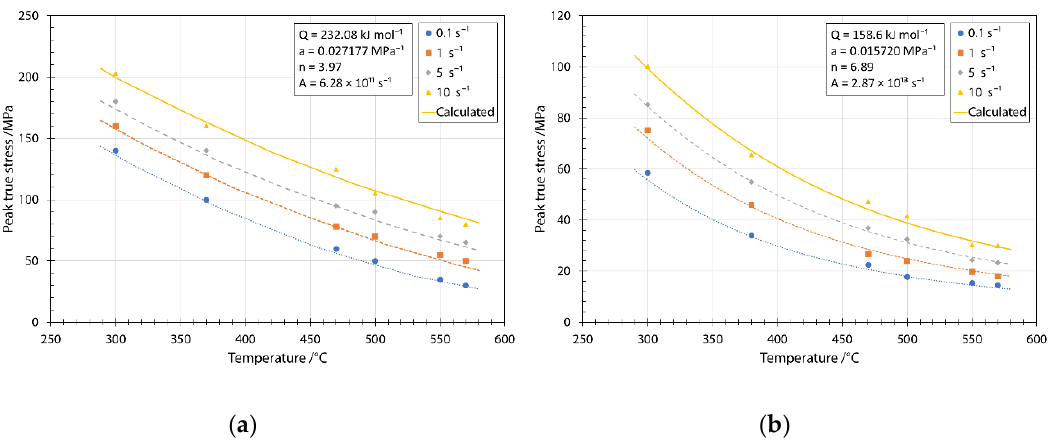
Figure 9. Temperature dependence of an experimental and calculated peak true stress values for various strain rates: ( a ) direct press extruded Al 1080 powder and ( b ) conventional direct press extruded aluminum AA 1050 alloy.